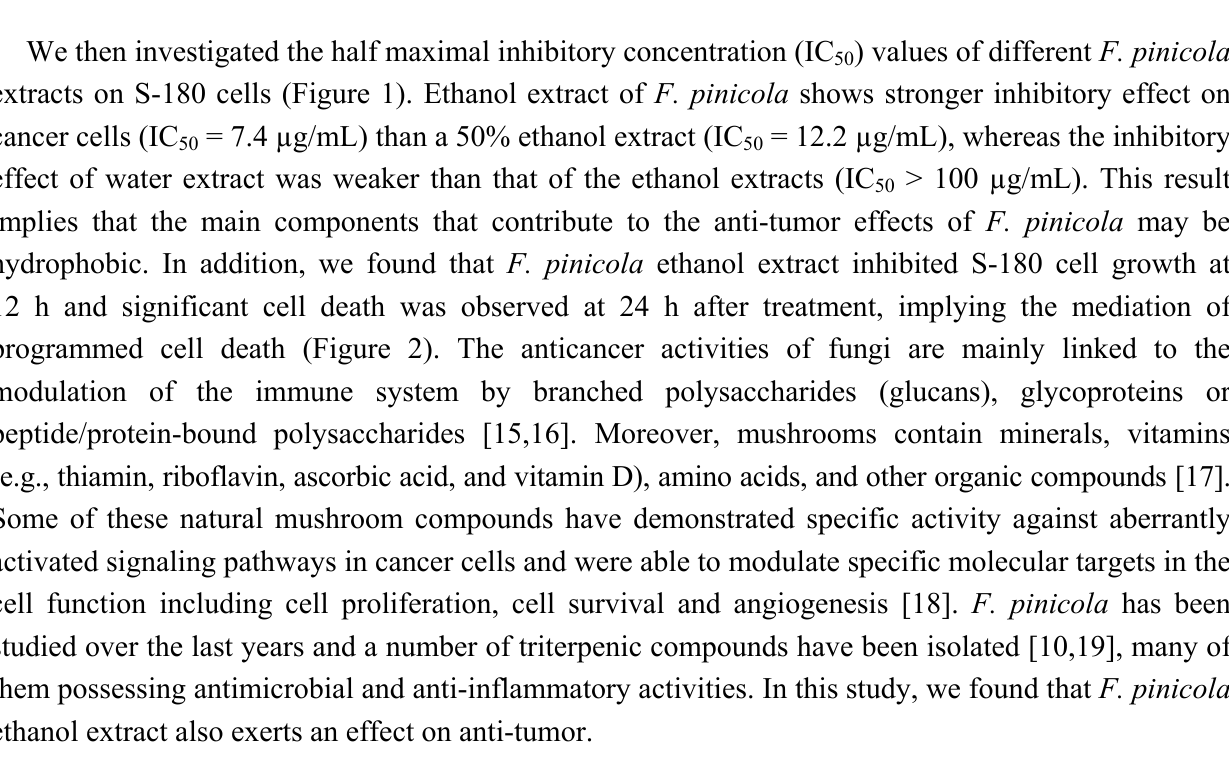
Figure 1. Anti-tumor effect of different F. pinicola extracts on S-180 cells. Sarcoma S-180 cells were treated with different F. pinicola extracts at indicated doses for 24 h. Cells were then incubated with 0.2 mg/mL MTT in culture medium for 4 h. MTT reagent was discarded and DMSO was added. The absorbance was measured at the wavelength of 570 nm. The data is expressed as means ± S.E.M. and obtained from three independent experiments with four replicates for each experiment. * p < 0.05, ** p < 0.01 and *** p < 0.001 compared with the control